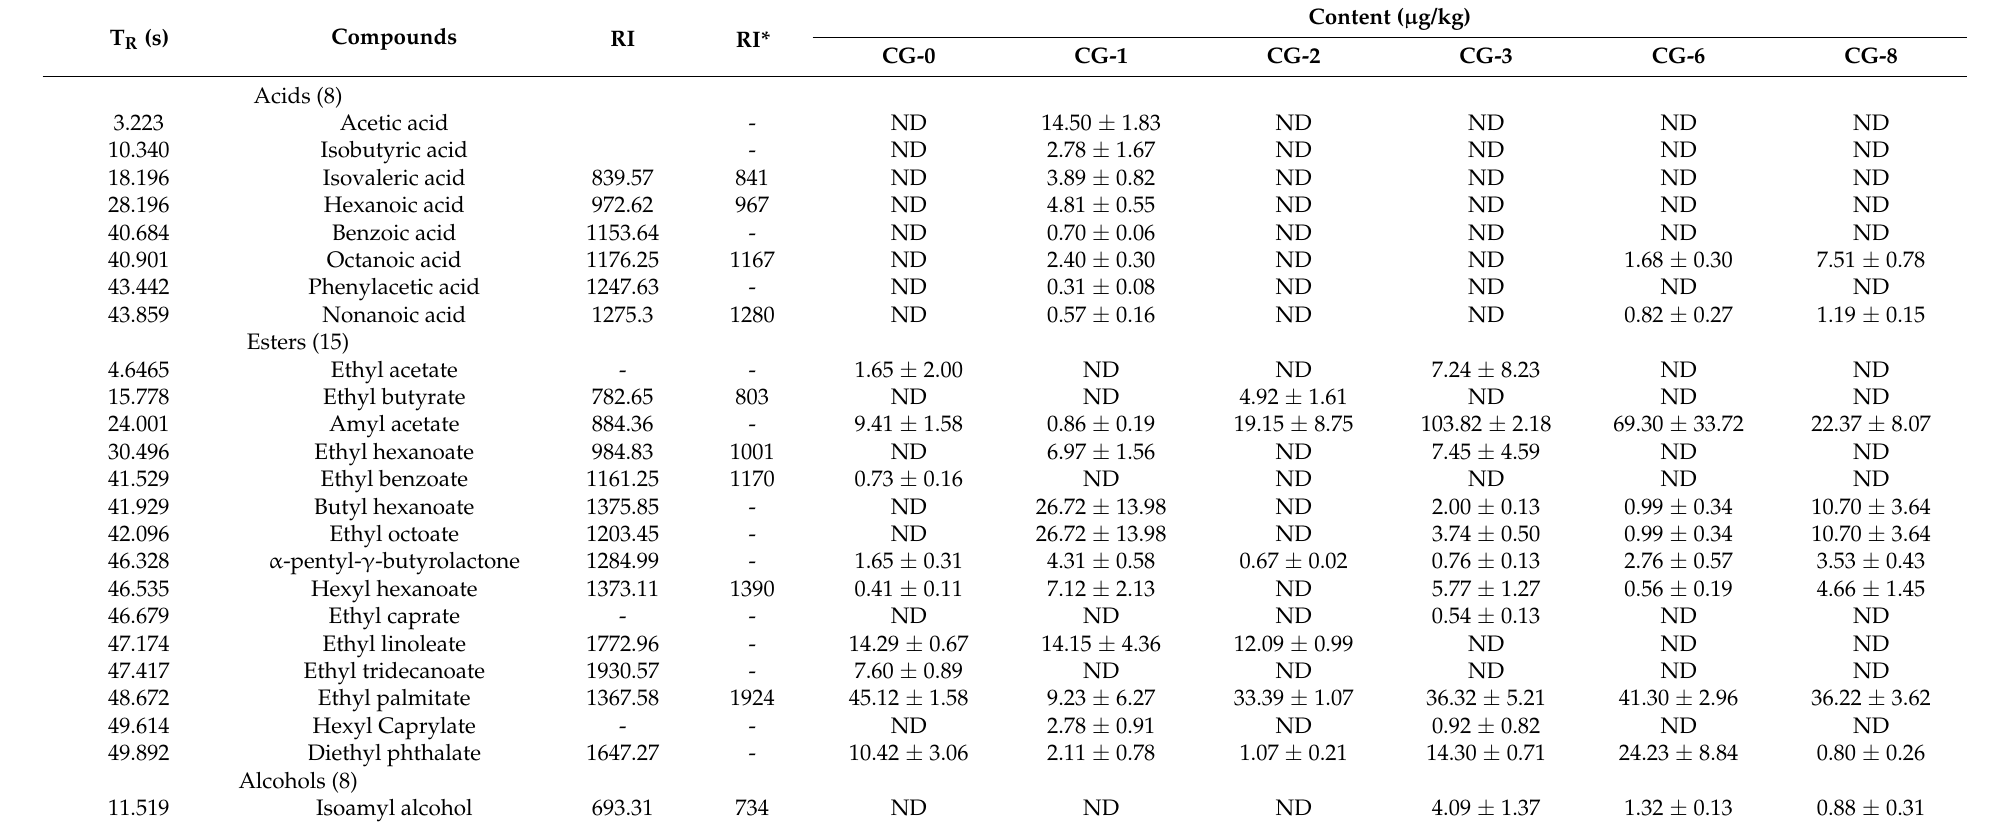
Table 1. Volatile flavor compounds of Caishiji soybean paste in different fermentation stages by